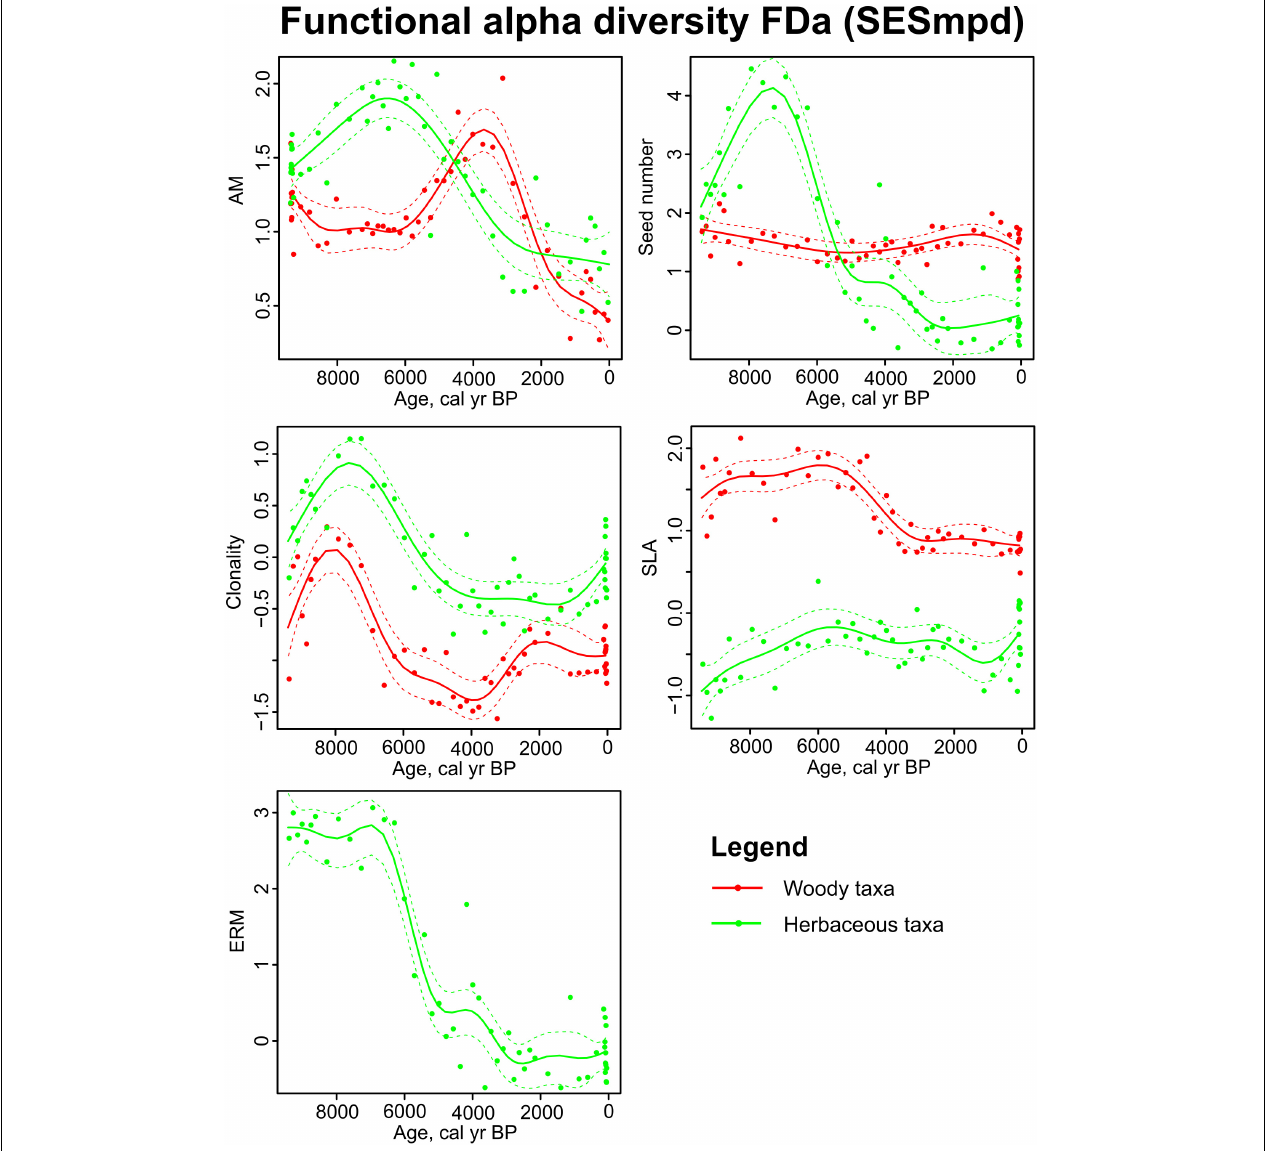
FIGURE 6 | Sedimentary pollen based reconstructions of functional alpha diversity (FDa) in Kanna spring fen. Generalized additive models in relation to time for woody (red line) and herbaceous taxa (green line). FDa is expressed as a standardized effect size of mean pairwise distance (SESmpd). Red and green dashed lines enclose the 95% confidence intervals of trend lines. Abbreviations of the trait names are explained in Table 1